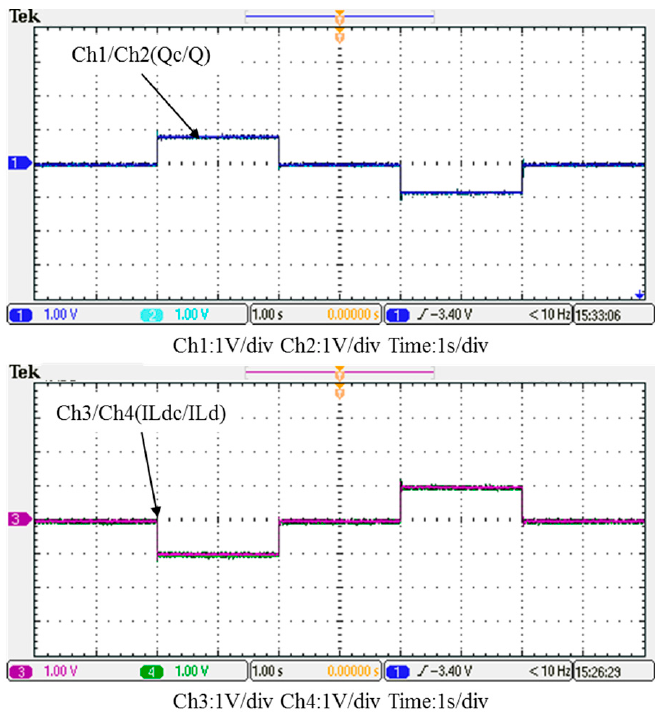
Figure 26. Detailed view of Figure 24: ( a ) near t 1 ; ( b ) near t 2 .